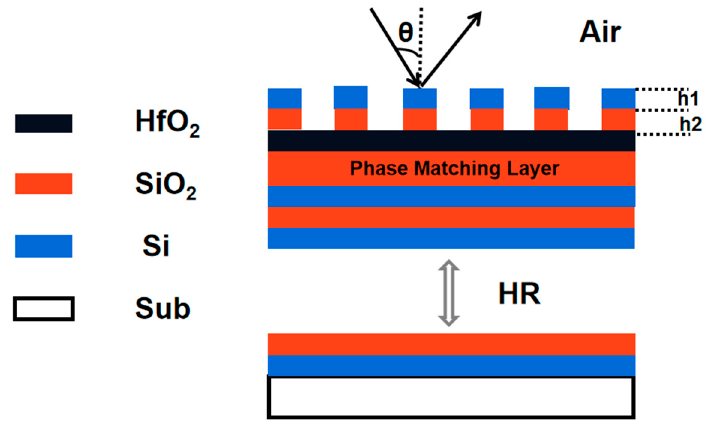
Figure 1. Brief structure of the MDG. The reflective DBRs are on the substrate, with a layer of phase match SiO 2 and a layer of etch stop HfO 2 subsequently. The grating consists a hybrid layer of Si and SiO 2 .